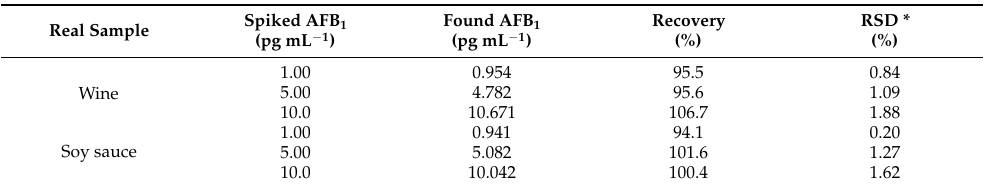
Table 1. Recovery of low-concentration AFB 1 in wine and soy sauce for the application of biosensors in a real matrix.